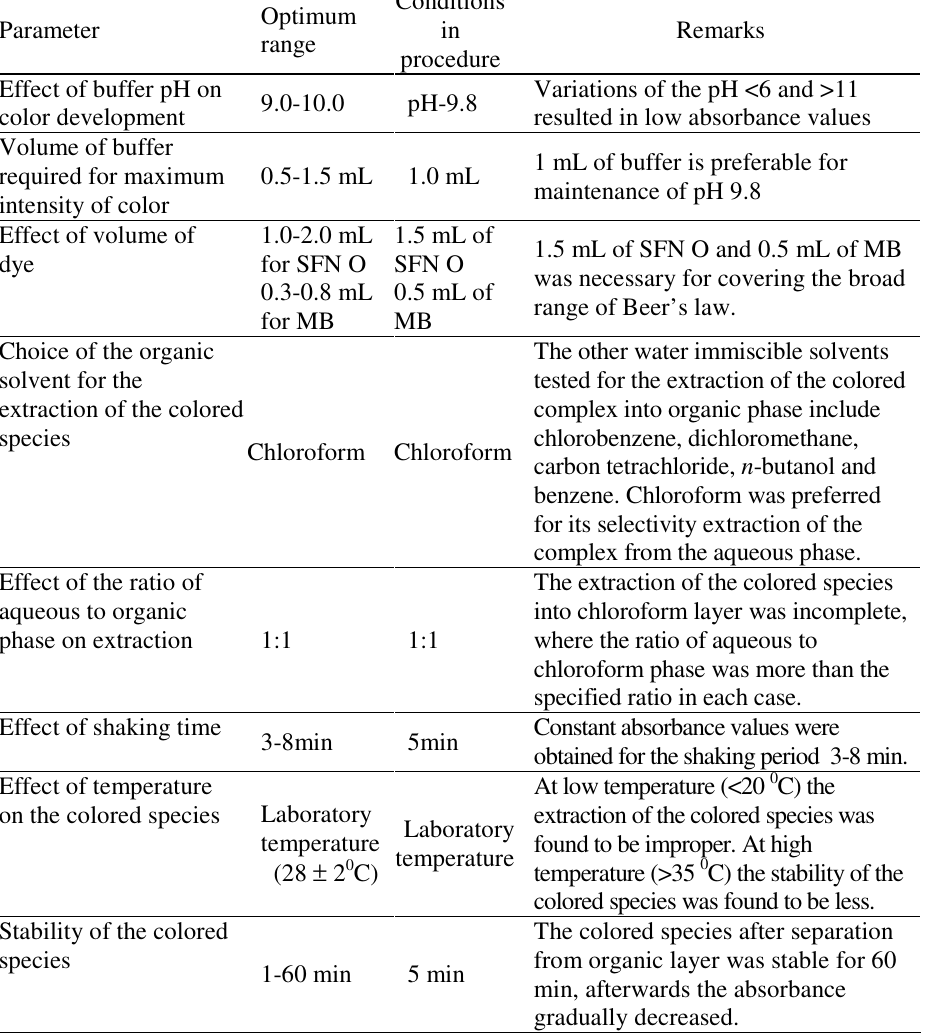
Table 1. Optimum conditions established for SFN O and MB